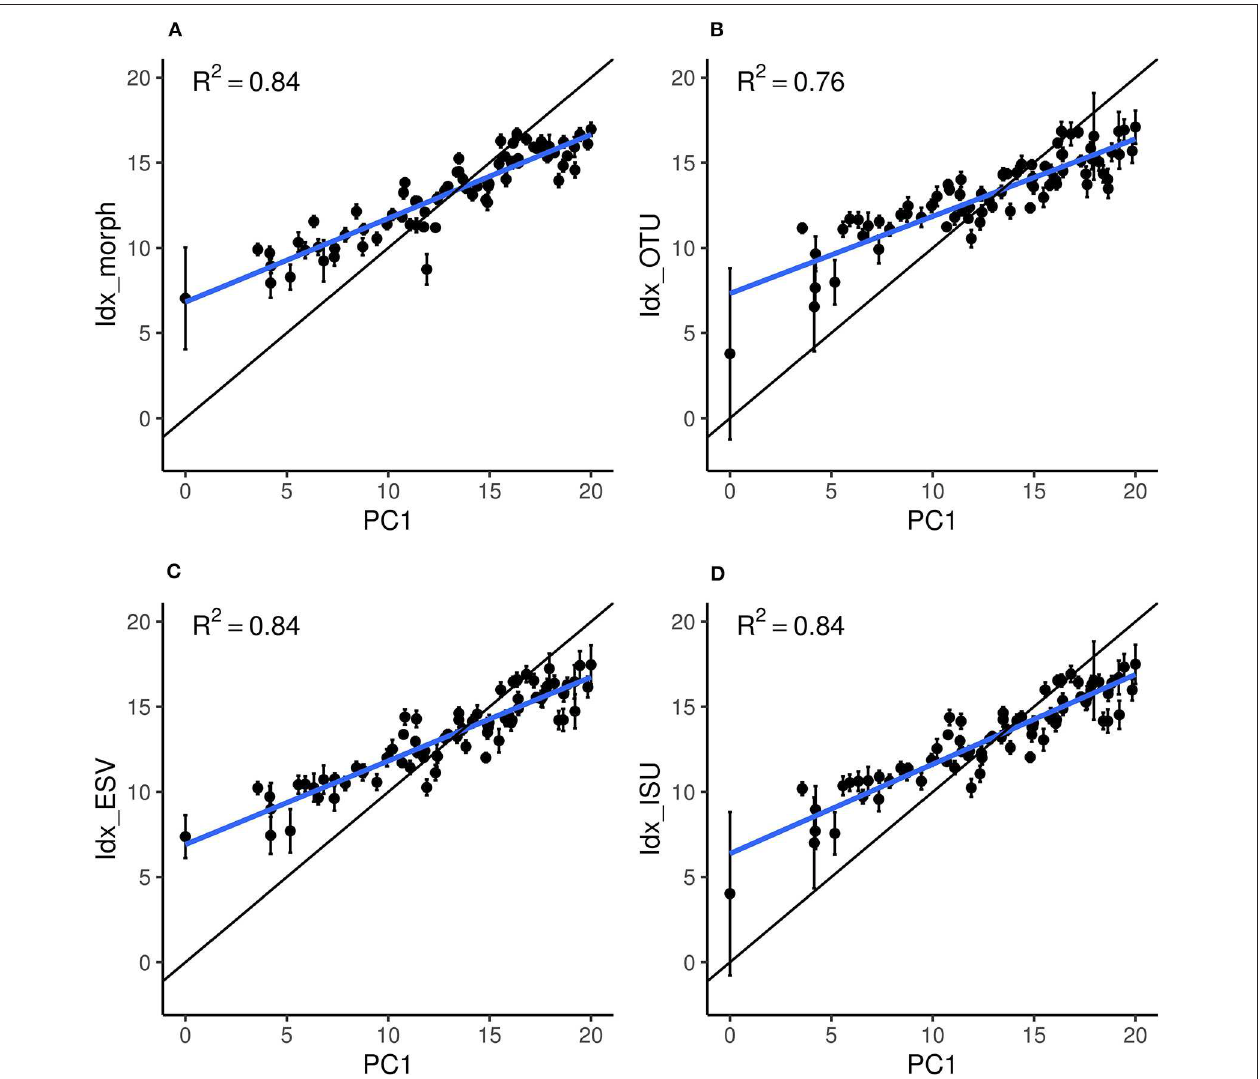
FIGURE 5 | Relation between the site scores on the reference gradient (PC1) and the scores estimated by each index: (A) Idx_morph, (B) Idx_OTU, (C) Idx_ESV, and (D) Idx_ISU. Black dots and error bars represent the average and standard deviations, respectively, over the 100 training repetitions. The thick blue line represents the estimated linear regression between PC1 and the index values. The black line materialize the perfect equivalence between PC1 and the indices (i.e., the optimal 1:1